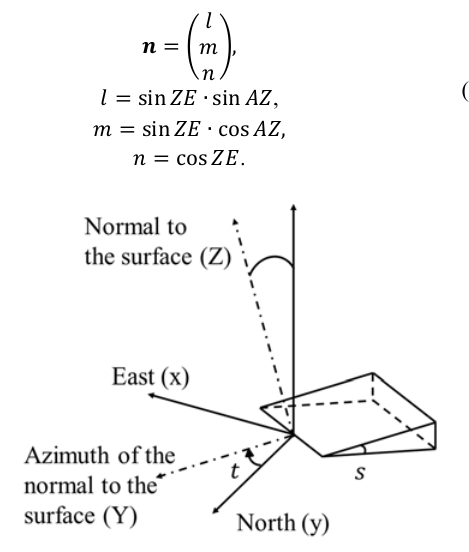
Figure 4. Transformation of the local coordinate. s and t are the slope elevation and azimuth angles,